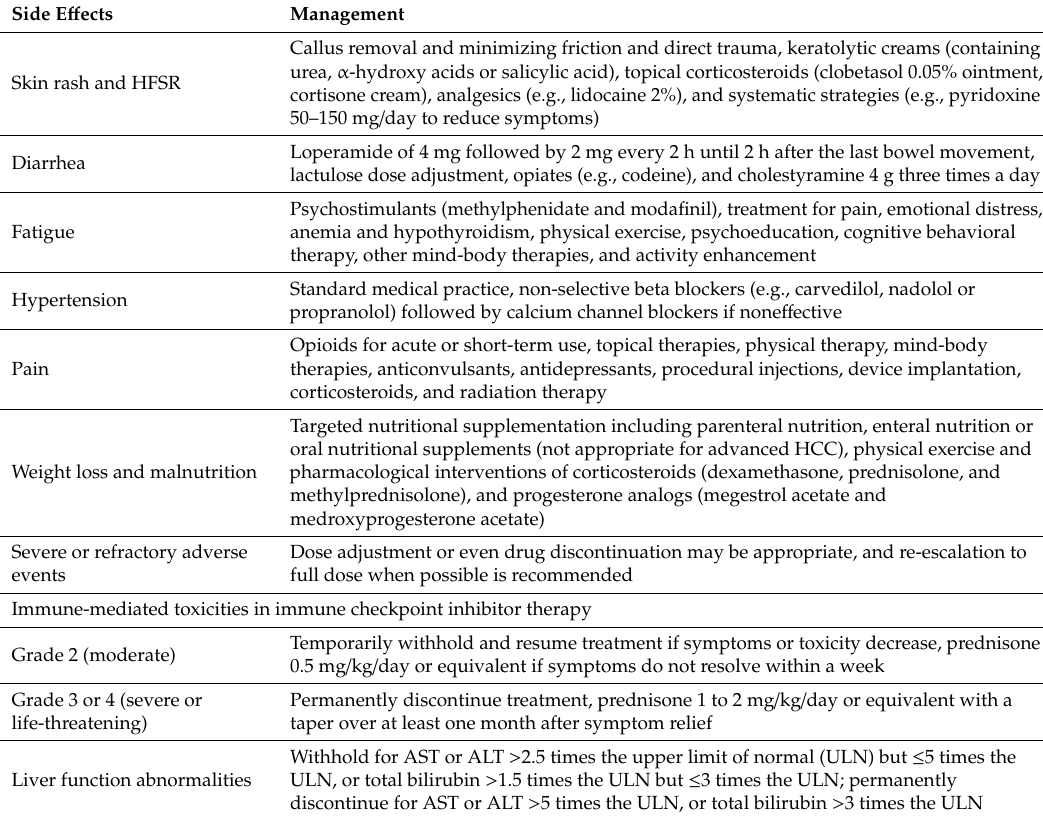
Table 3. Management of drug toxicities and side e ff